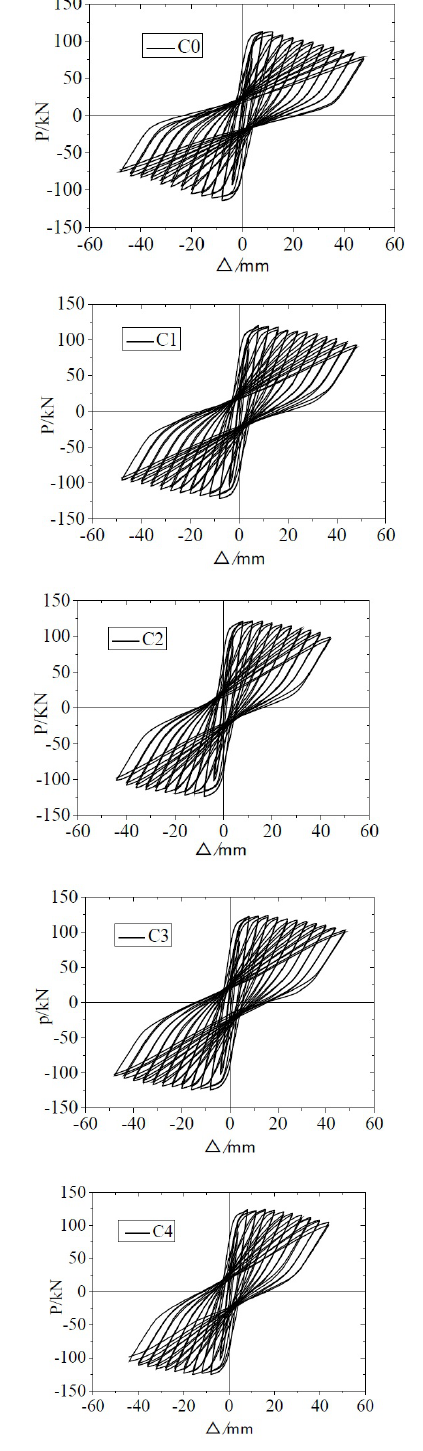
Figure 18: Hysteretic curves of the specimens with different num- bers of reinforcement